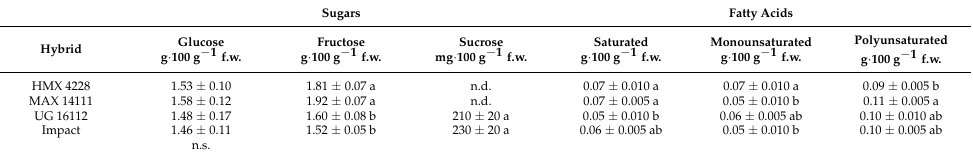
Table 5. Sugars and fatty acids in diced tomato fruits produced by four hybrids. Sugars